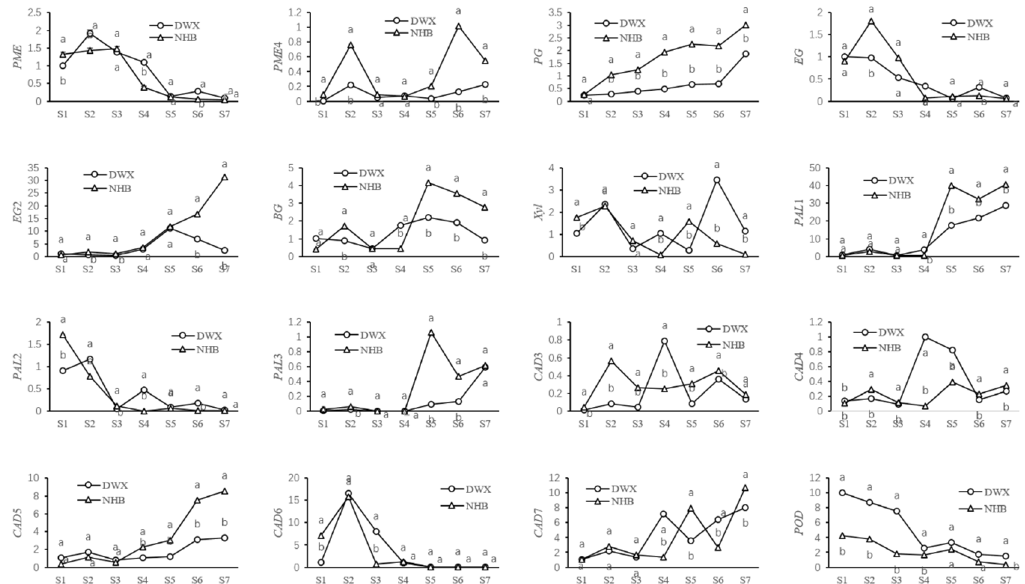
Figure 4. Dynamic changes of pectin methylesterase ( PME ), polygalacturonase ( PG ), endoglucanase ( EG ), β-glucosidase ( BG ), cellobiohydrolases ( CBH ), xylanase ( Xyl ), phenylalanine ammonia lyase ( PAL ), cinnamyl alcohol dehydrogenase ( CAD ), and peroxidase ( POD ) gene expressions at seven different stages of loquat fruit development and ripening. The stages numbered on the x -axis correspond to those presented in Figure 1. Values are means ± SD of three biological replicates. Variance analysis was carried out independently for each of the seven developmental stages studied. The different lowercase letters in the line charts indicate significant differences ( p < 0.05).